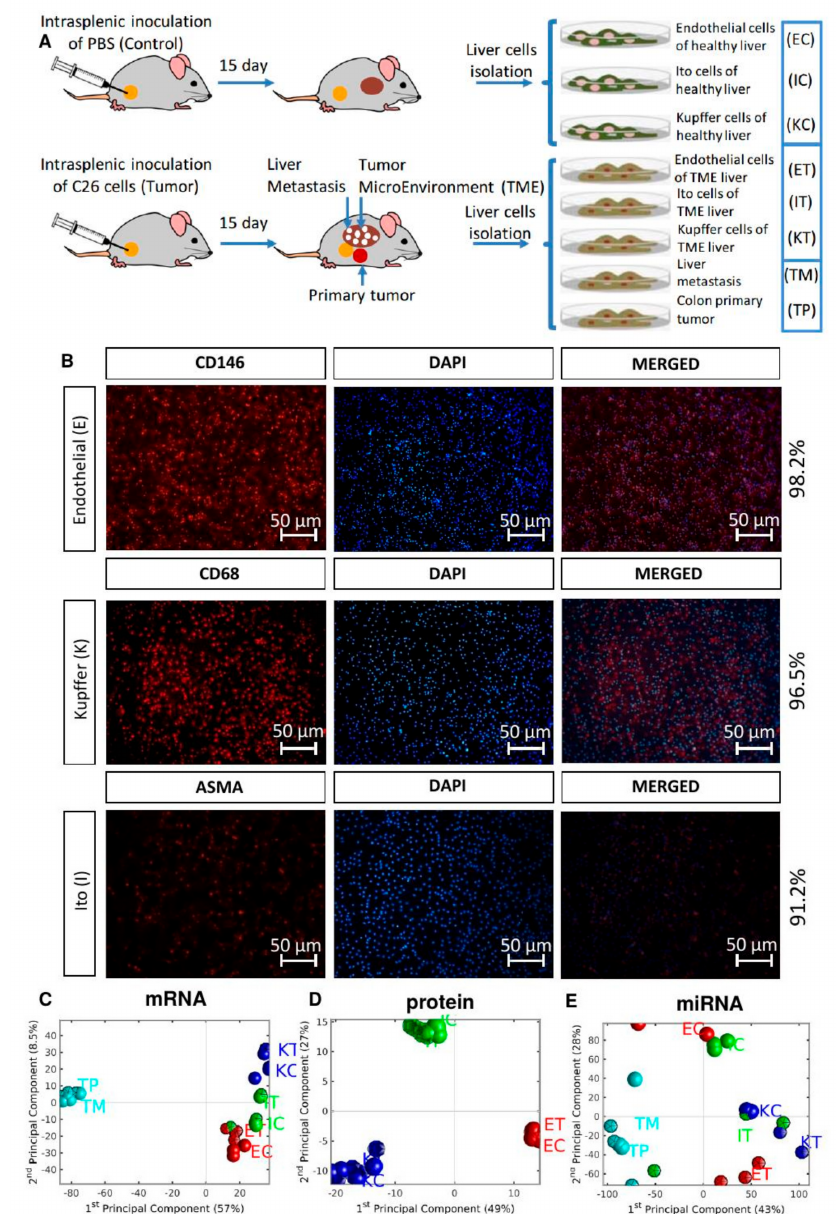
Figure 1. Experimental design and global omics analysis. ( A ) Two groups of mice were inoculated with C26 murine colon cancer cells and with PBS (Control). After 15 days, the mice were perfused, and after PercollV R gradient centrifugation, three types of liver cells were collected, namely liver sinusoidal endothelial cells (E), Ito cells (I) and Kup ff er cells (K), from control (C) and TME (T), and isolated to perform omics experiments (gene expression, miRNA expression microarrays and proteomics). TP and TM denote the CRC primary and tumor liver metastasis cells, respectively. ( B ) Cell purity was checked via immunochemistry using specific antibodies to detect endothelial (CD146), Kup ff er (CD68), and Ito (ASMA) cells. ( C – E ) PCA plots of mRNA, protein and miRNA expression. Red, blue, and green symbols mark endothelial, Kup ff er, and Ito cells, respectively. TME cells are depicted with dodecahedra, and controls with spheres. For each mRNA sample we used 4 biological replicates; for each miRNA sample 3 biological replicates, except 2 for ECs and KTs; for the proteomics data we used 9 biological replicates for ECs, 7 for ETs, 6 for ICs and ITs, and 5 for KCs and